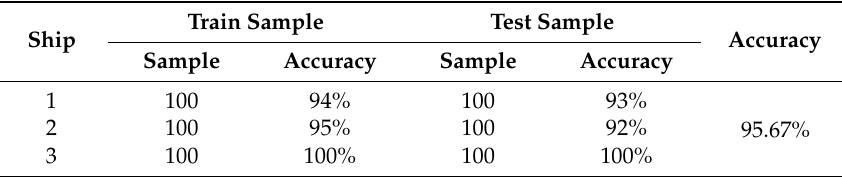
Table 9. The center frequency classification results after denoising.